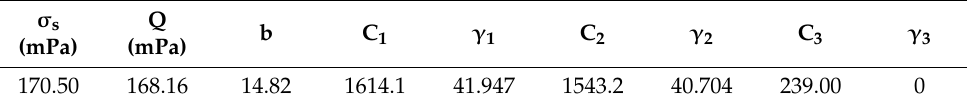
Figure 2. Cyclic test, ( a ) loading and unloading curve and ( b ) stress–strain curve of the material. Table 1. Parameters of nonlinear isotropic/kinematic hardening model of steel alloy 1.0308.